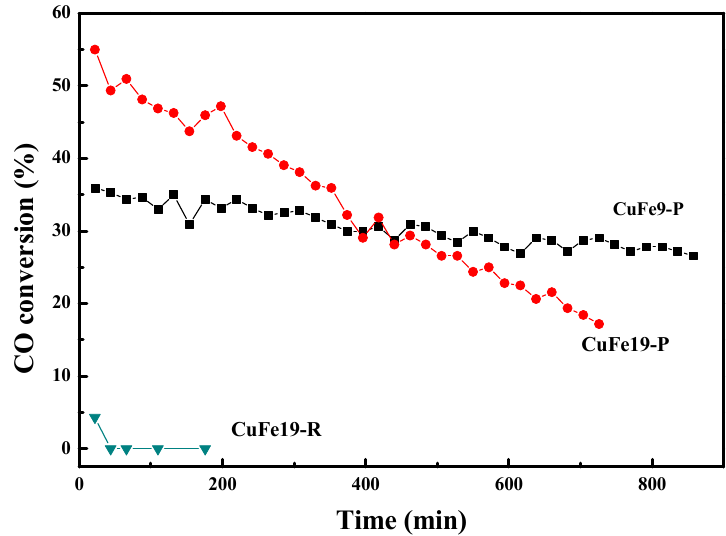
Figure 9. Water gas shift (WGS) reaction stability of CuFe19-P, CuFe19-R, and CuFe9-P. All samples were reduced at 250 °C for 3 h, reaction conditions: 250 °C 1vol.%CO/3vol.%H 2 O/He; 40,000 mL ∙ g − 1 ∙ h − 1 .